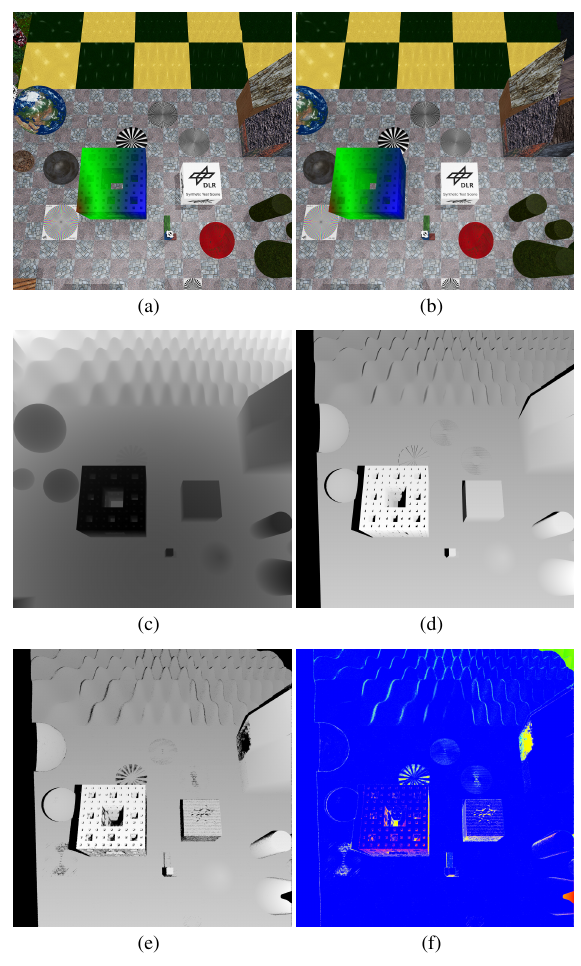
Figure 5. Stereo matching results for the synthetic 3D scene (a) Left image (b) Right image (c) Left perspective distance map from POV-Ray (d) Left reference disparity map (e) Left disparity map after matching (f) Deviation heat